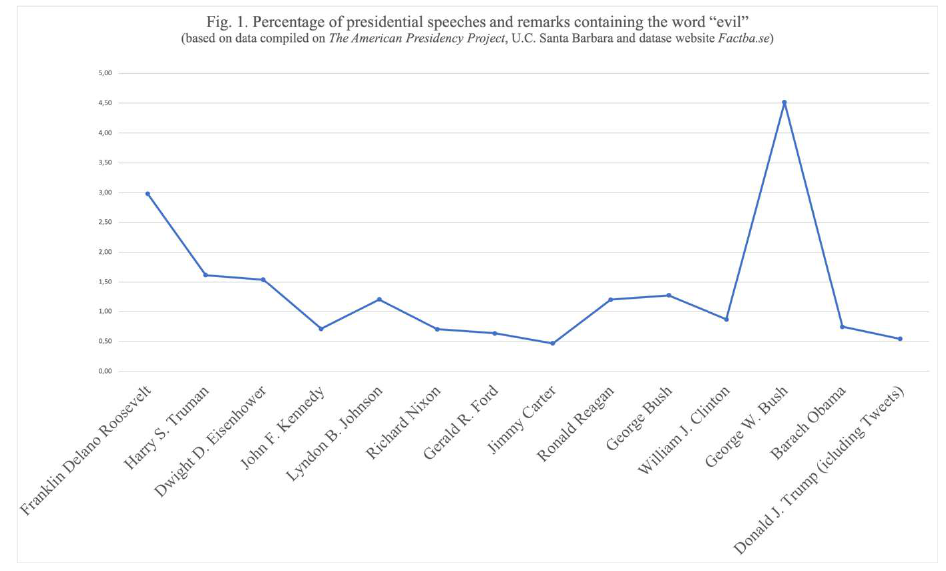
Based on data compiled on the American Presidency Project, UC Santa